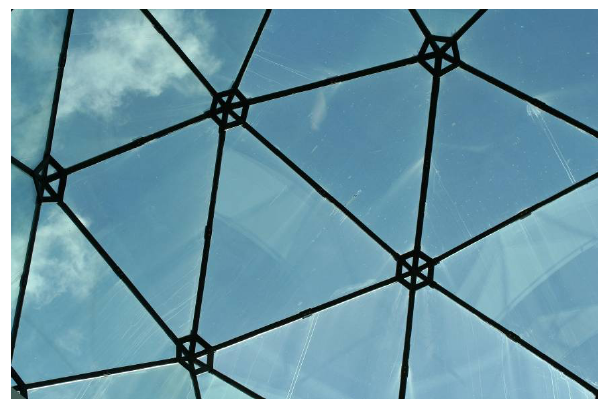
Figure 8: Open ring connection seen from the interior (Photo: Gerard